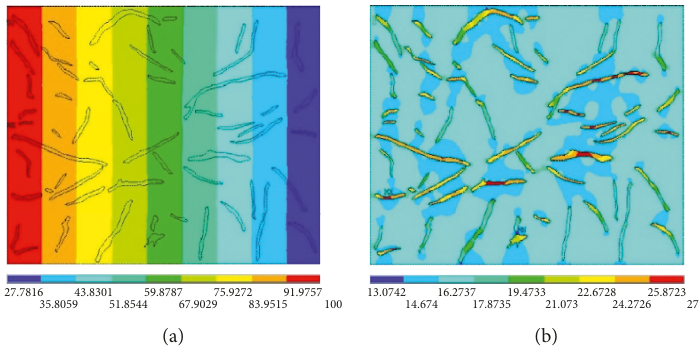
Figure 5: The results of grey iron model: (a) temperature; (b) heat flux.